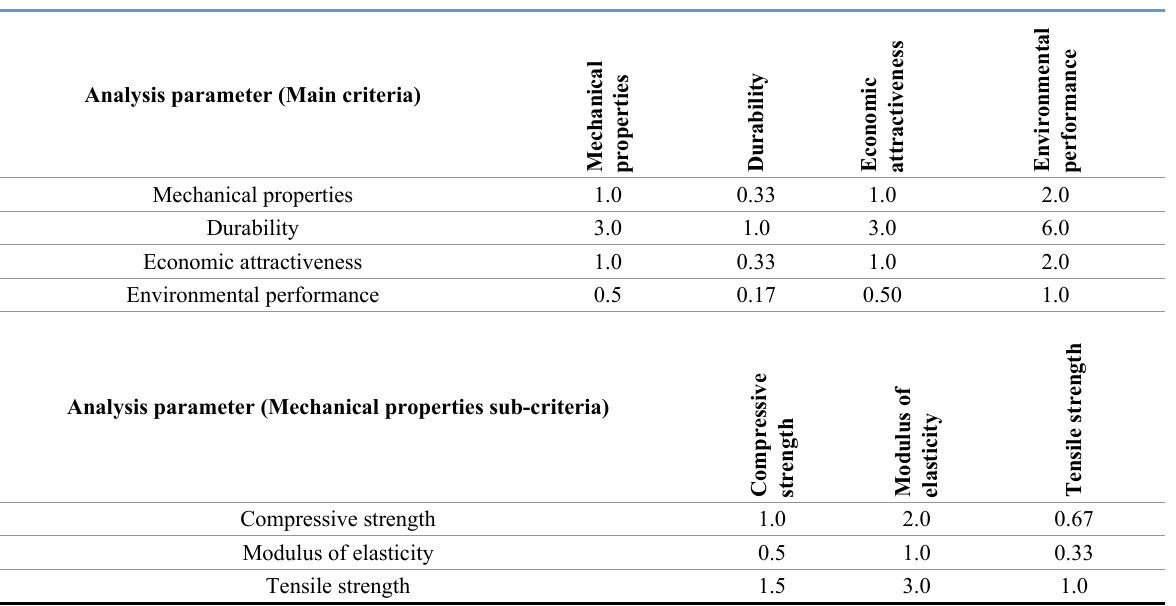
Table 4. Decision matrix of criteria, mechanical properties sub-criteria and durability sub-criteria (Scenario 1 - Industrial floor).